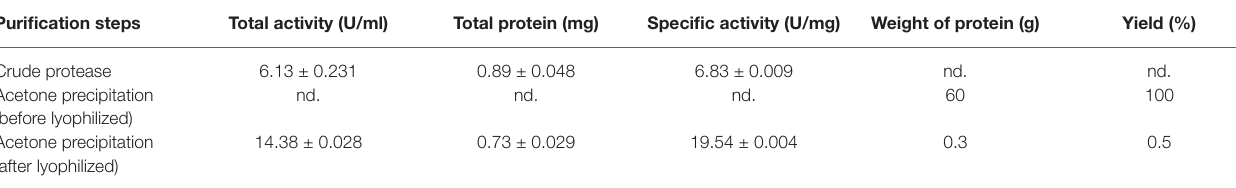
TABLE 4 | Bacillus velezensis PM 35 exhibited the specific activity of crude protease and purified protease. Purification steps